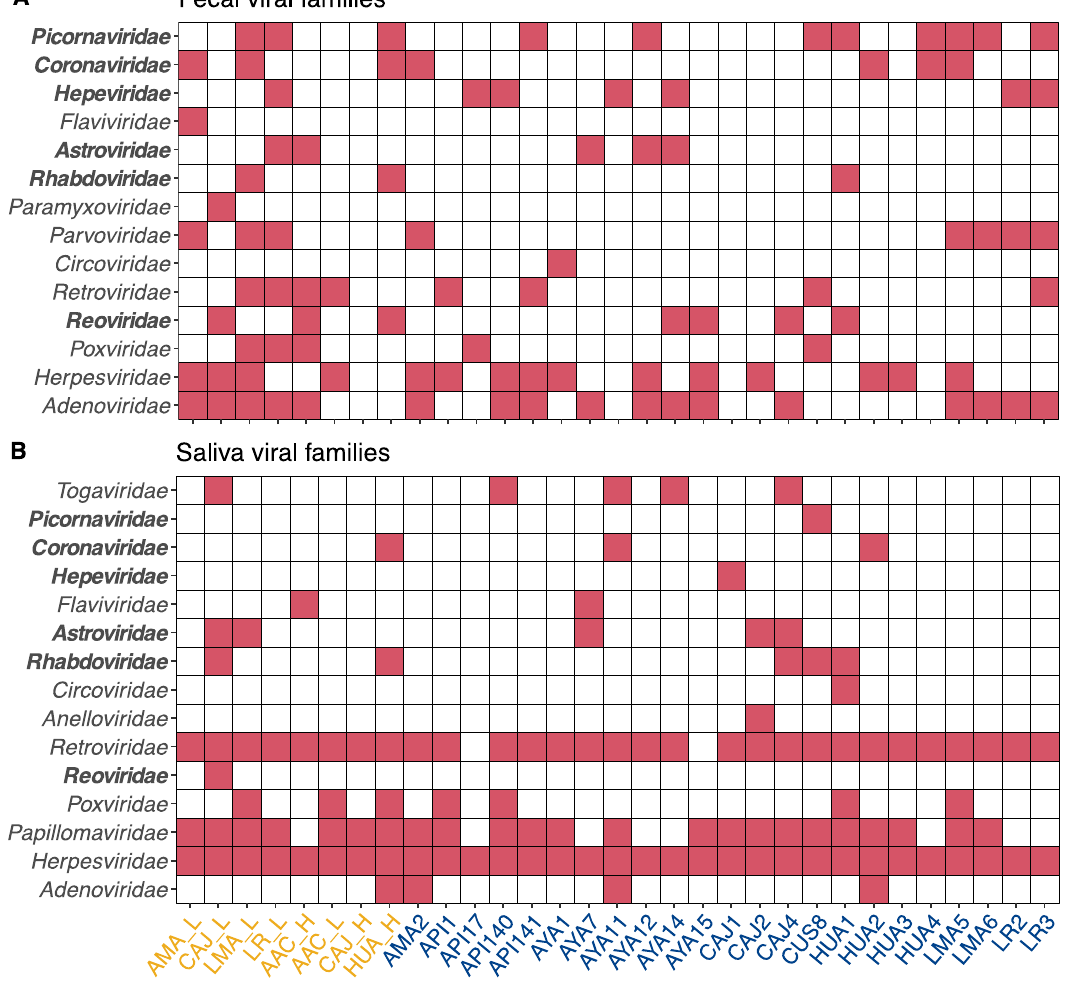
Figure 1. Heatmaps showing the presence (red) or absence (white) of contigs matching to mammal-infecting viral families found in ( A ) feces and ( B ) saliva pools from vampire bat metagenomic datasets. Pools are named and colored according to original studies in yellow [33] and blue [34]. Viral families studied in depth are indicated in bold.